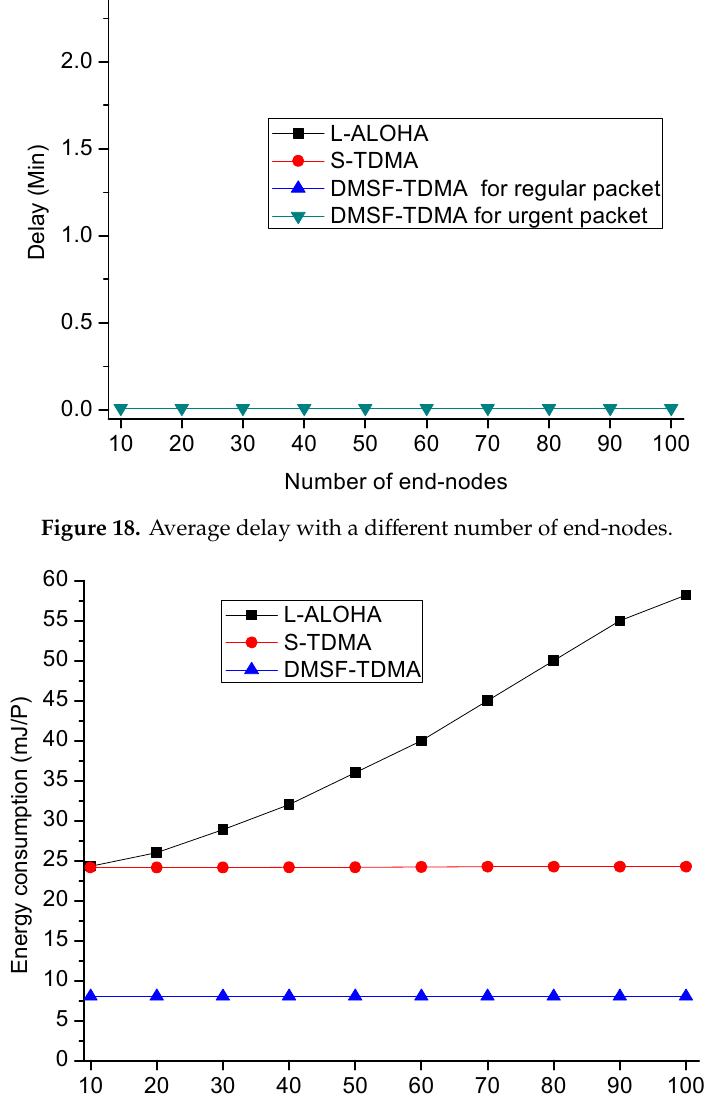
Figure 19. Average energy consumption with a different number of end-nodes.